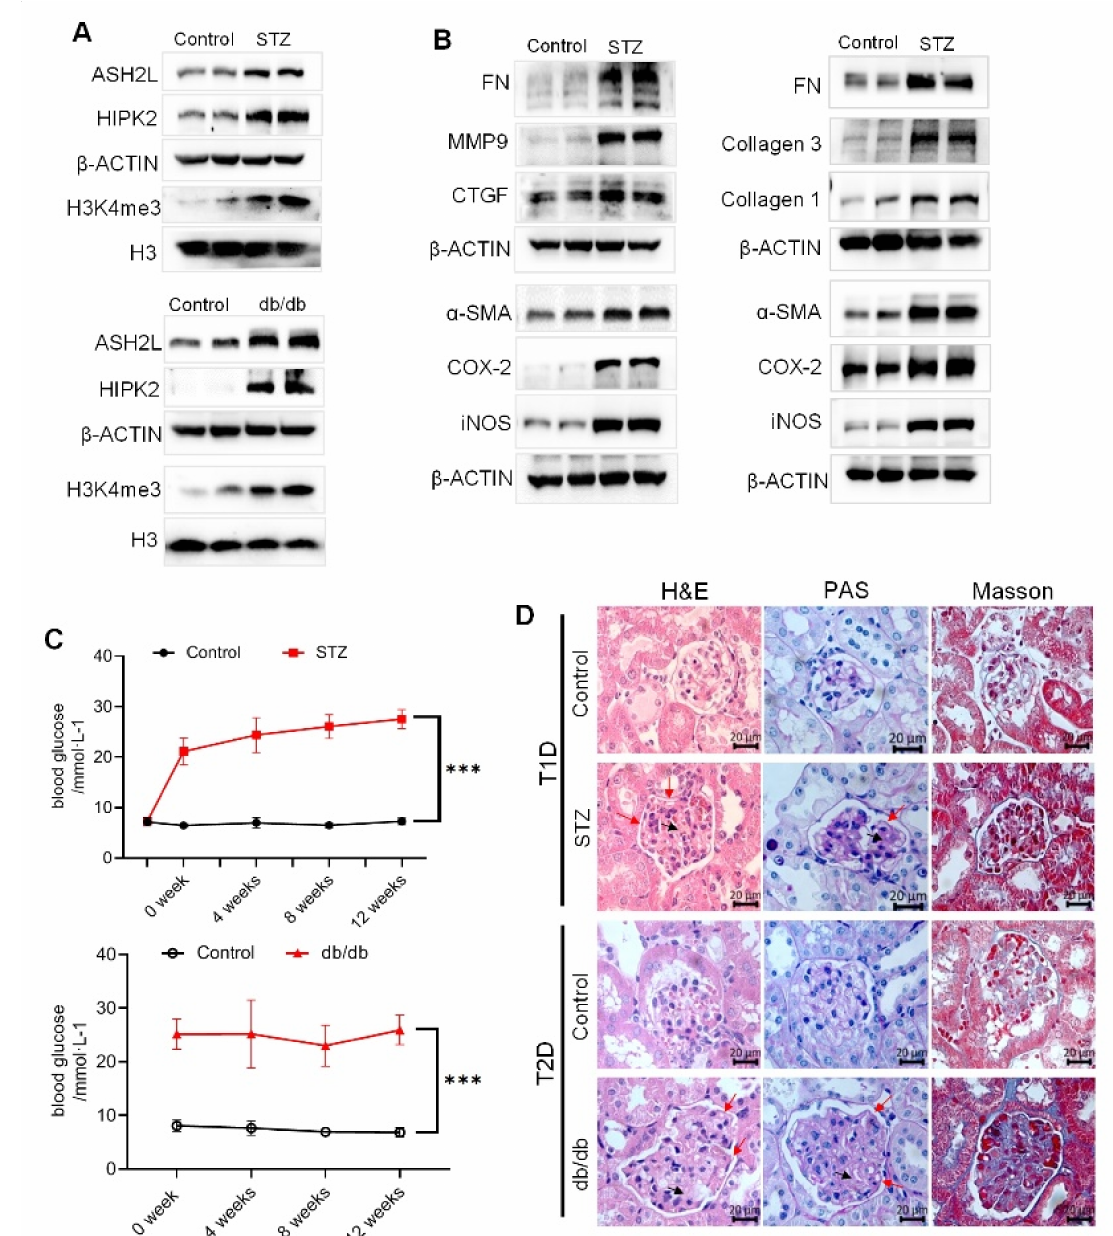
Figure 6. Diabetic mice show renal injury and upregulated ASH2L and HIPK2 allied with fibrosis and inflammation. ( A ) Western blot analysis of ASH2L, HIPK2, and H3K4me3 in STZ-induced mice ( n = 5) and db/db mice ( n = 3). ( B ) Western blot analysis of fibrosis markers and inflammatory markers in STZ-induced mice ( n = 5) and db/db mice ( n = 3). ( C ) Blood glucose of STZ-induced mice ( n = 10) and db/db mice ( n = 6). Data are shown as mean ± S.D and *** p < 0.001. ( D ) Representative images of H&E staining, PAS staining, and Masson’s staining of mice